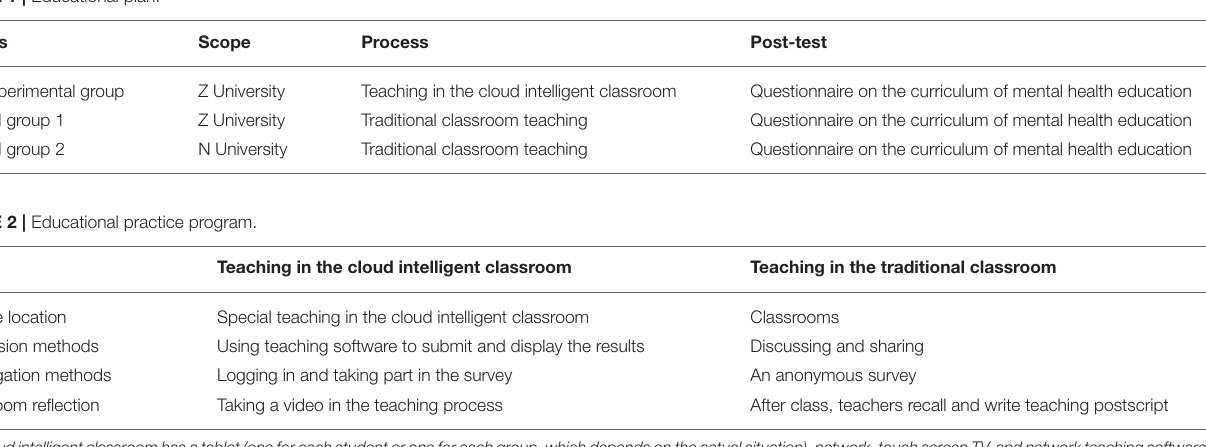
TABLE 1 | Educational plan.